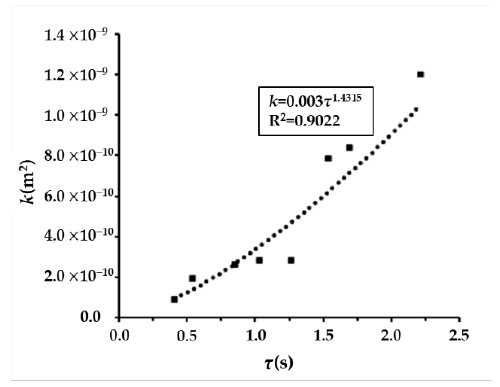
Figure 8. Relationship between relaxation time and permeability.